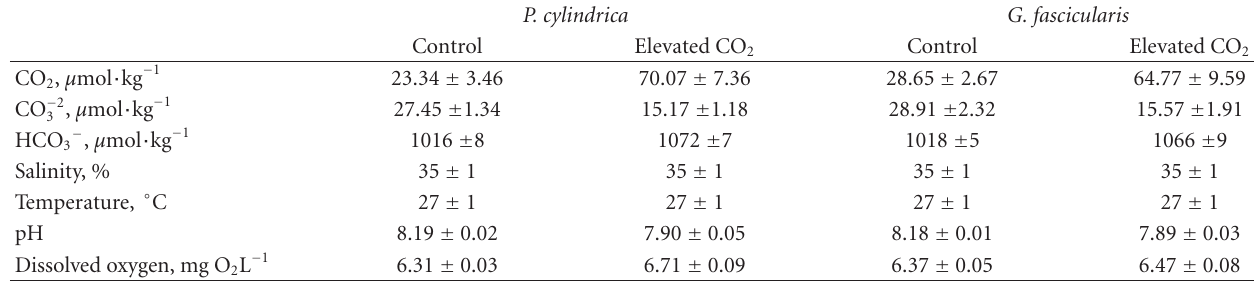
Table 1: Water quality parameters (mean ± standard deviation) in the control and experimental aquaria. The reading was based on day 0 and subsequent daily measurements for fifteen days ( n =